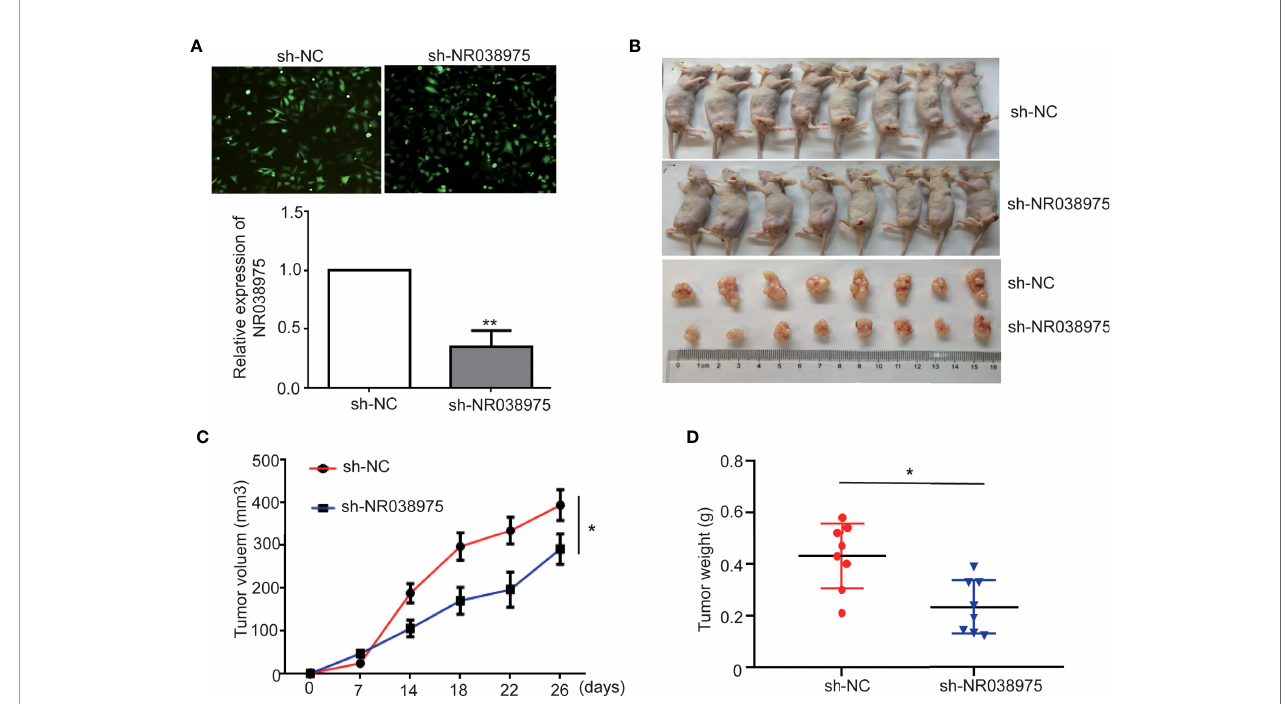
FIGURE 3 | Knocking down NR038975 inhibits gastric cancer (GC) cell growth in vivo . (A) The stable and low expression of NR038975 was detected in SGC-7901 GC cells using immuno fl uorescence microscopy and real-time PCR after transfection with a lentivirus harboring the full-length human NR038975 sequence. (B) The growth of sh-NC-SGC-7901 cells and sh-NR038975-SGC-7901 cells that were injected subcutaneously into nude mice (n = 8). (C) Growth curves for the xenograft NR038975-knockdown tumors, *p < 0.05. (D) Tumor weights of the xenograft NR038975-knockdown tumors were measured, *p < 0.05, **p <